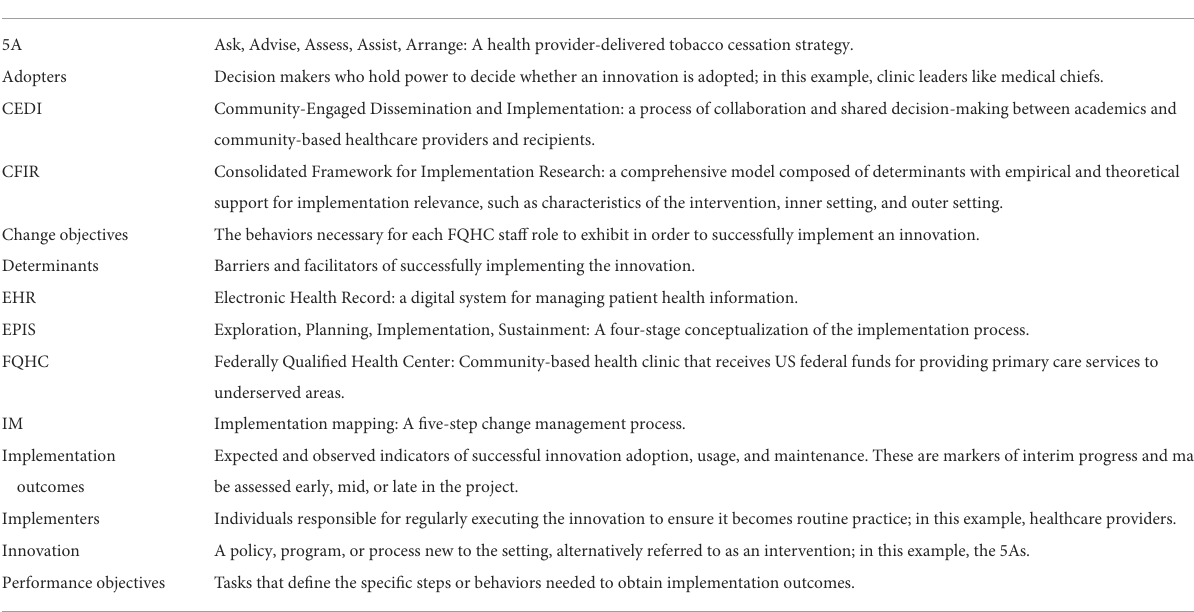
TABLE 1 Definitions of key